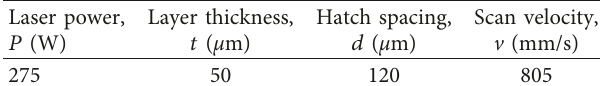
Table 2: Process parameters.